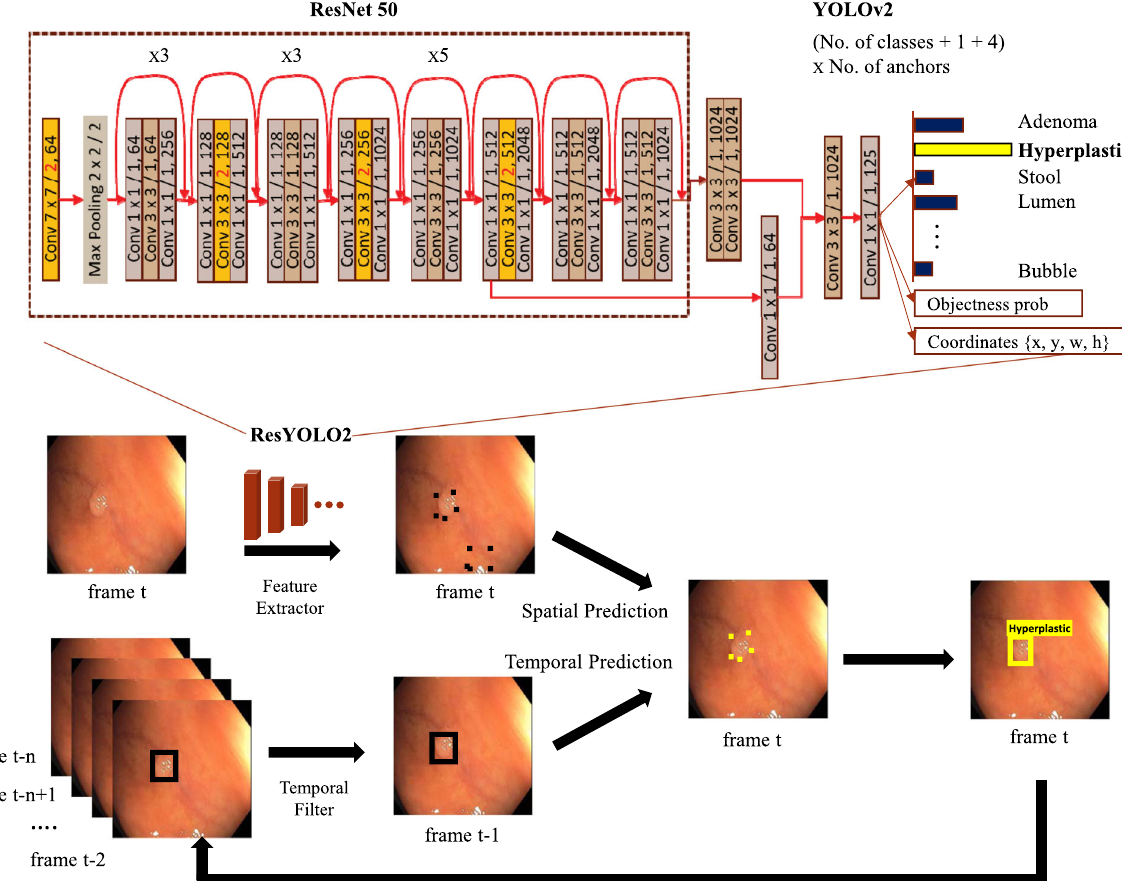
Fig. 4 An overview of the algorithm design of AI-doscopist. AI-doscopist was constructed based on ResNet50, YOLOv2, and a temporal tracker. The model was found to perform reasonably well with a good trade-off between speed and accuracy in earlier studies. The feature extractor was adopted from a modi fi ed version of ResNet50. A one-stage object detector, YOLOv2, was selected for localising objects in each image in real-time. Predicted boxes that were unlikely polyp were removed and overlapped predicted boxes were combined using the non- maximum suppression method. Temporal information was incorporated by using the majority votes of the prediction results within a sliding window.